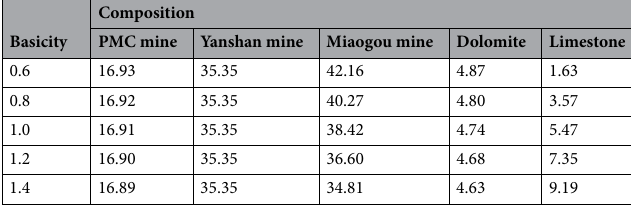
Table 2. Composition of pellets with different